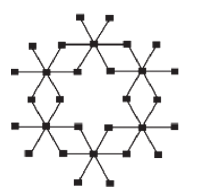
Figure 21: Unit cell (bismuth